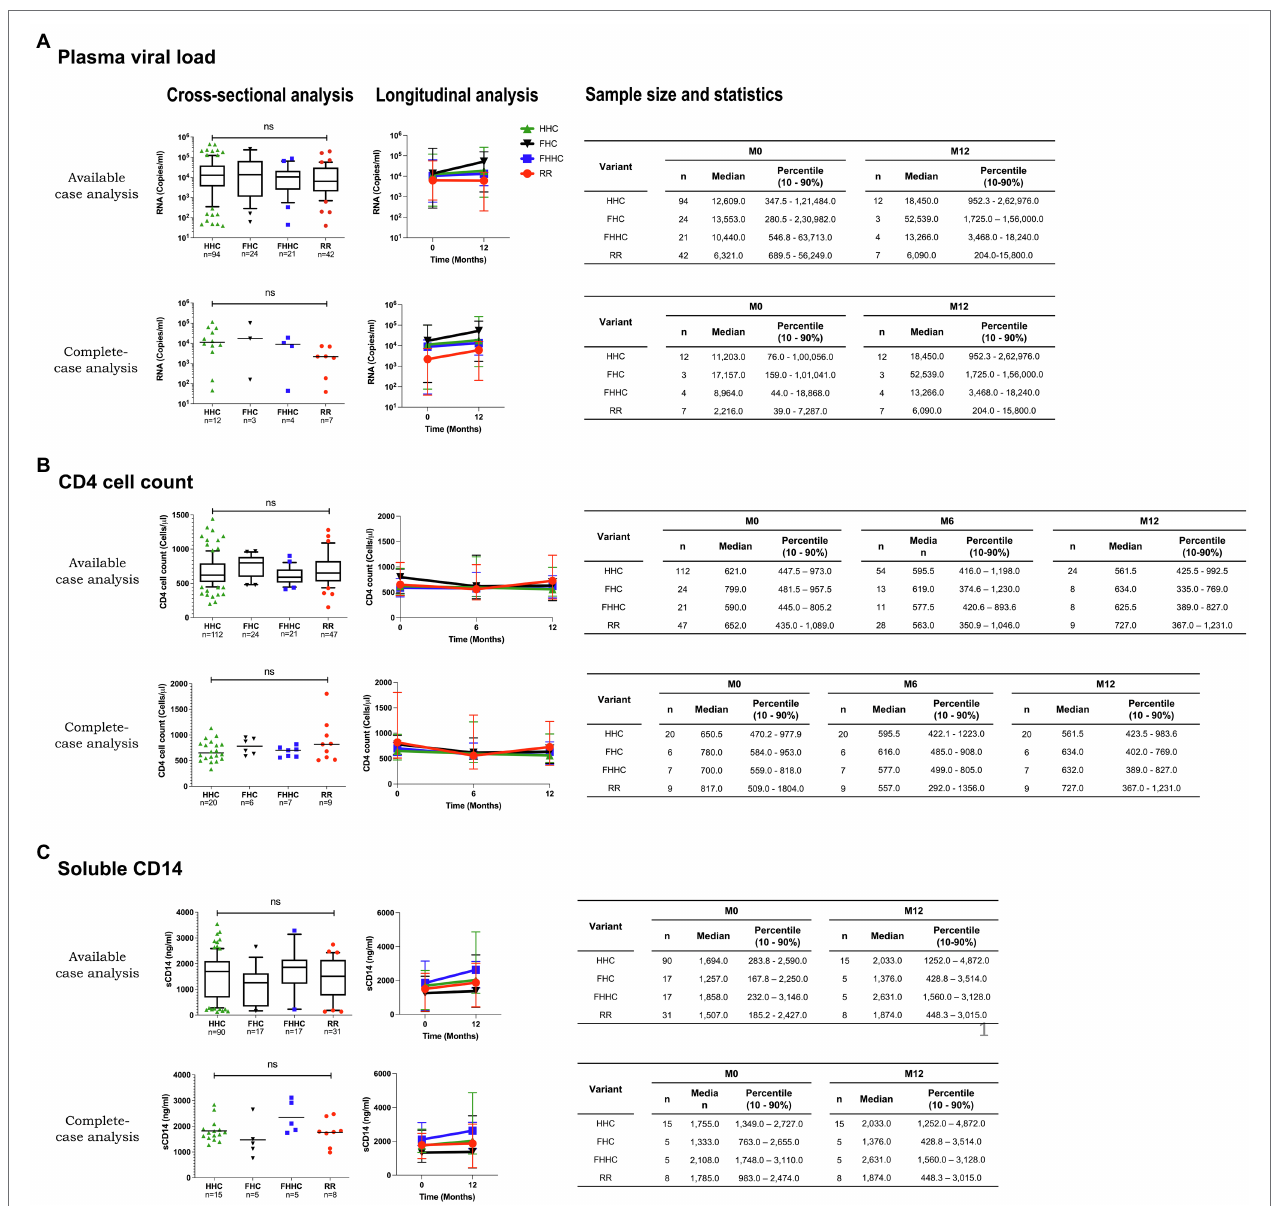
FIGURE 4 | Cross-sectional and longitudinal analyses of prognostic markers. (A) Plasma viral load, (B) CD4 cell count, and (C) soluble CD14 levels of the four groups are presented at the baseline (left panels) and follow-up points (right panels). An available-case and complete-case analysis is presented for all the prognostic markers. The sample size used in each evaluation and the corresponding statistics are presented, in the tables. Given the limited sample numbers, the seven RR groups were pooled into a single double-RBEIII arm. Different LTR variant types are represented using different symbols and colors, as depicted. A non- parametric test, that is, the Kruskal-Wallis test, was applied for the statistical analysis of the plasma viral load. One-way ANOVA with Dunnett multiple comparison test was applied to CD4 cell count and sCD14. Two-way ANOVA was used for the comparison of the longitudinal